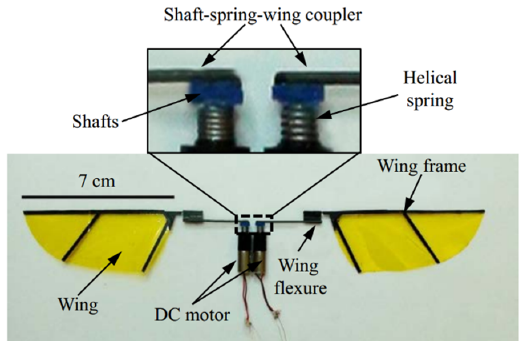
Figure 3. The prototype of a motor-driven flapping-wing